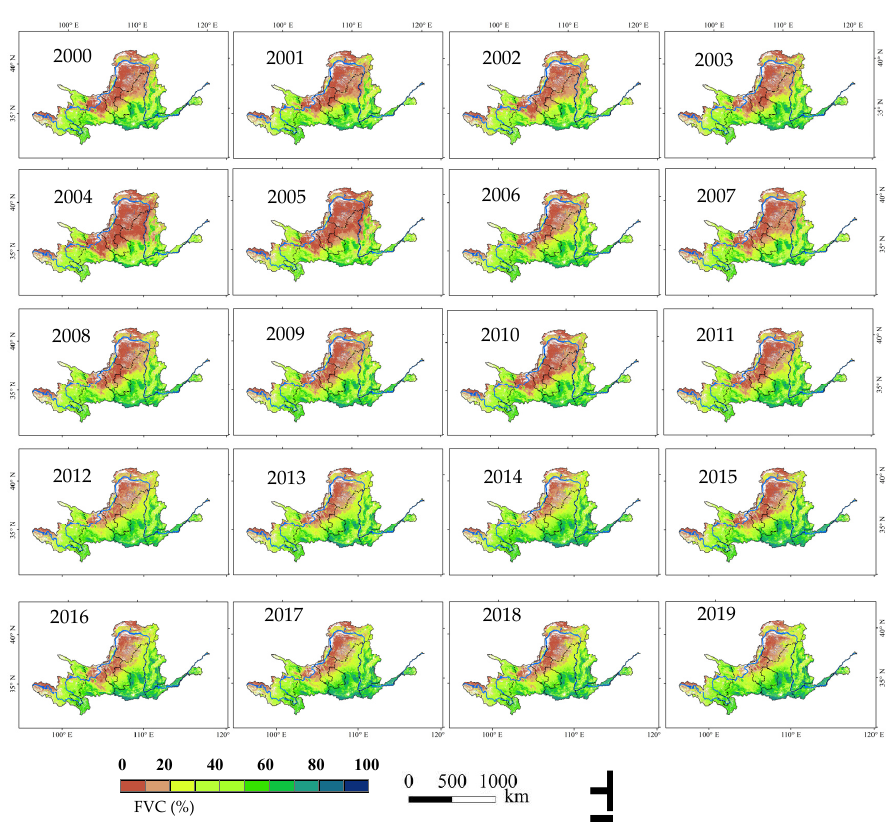
Figure 4. FVC distribution map of the YRB from 2000–2019.